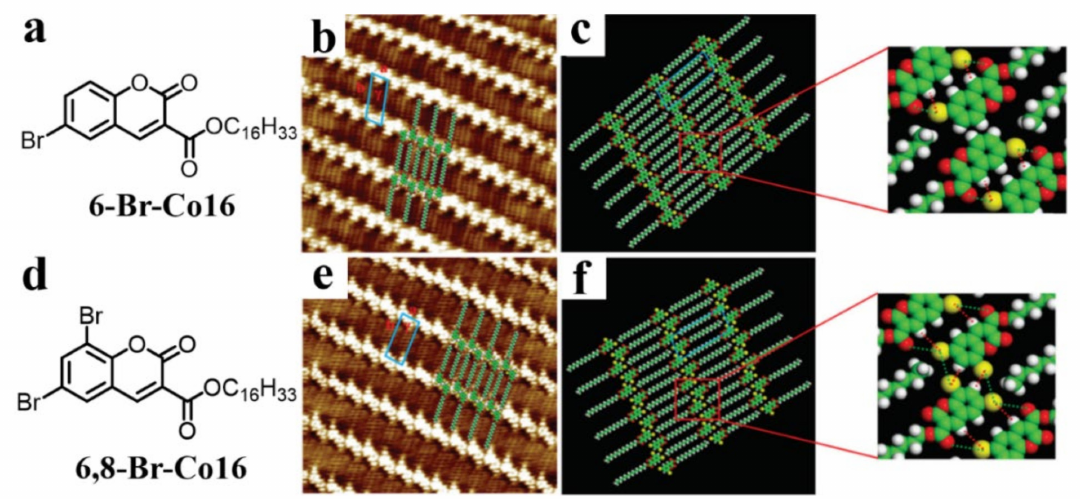
Figure 6. ( a , d ) Molecular structures of 6-Br-Co16 and 6,8-Br-Co16. ( b , e ) High-resolution STM images of the 6-Br-Co16 and 6,8-Br-Co16 physiosorbed monolayers at the 1-phenyloctane / HOPG interface. Scanning area: 20 × 20 nm 2 . ( c , f ) Proposed molecular models of ( b , e ). The inset shows the possible intermolecular bonds. Reproduced from [78] with permission from the Royal Society of